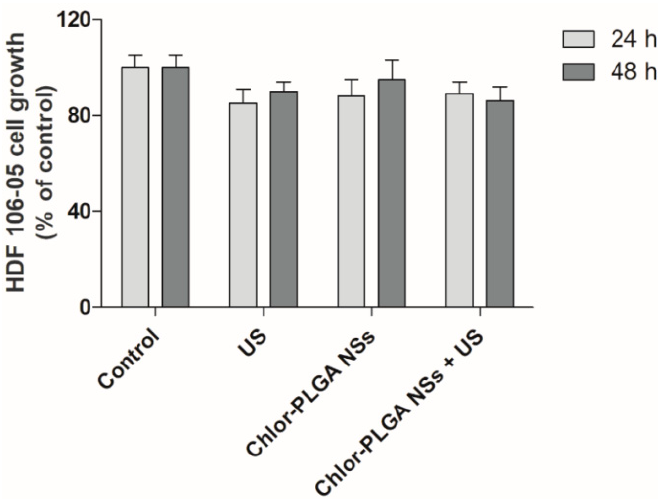
Figure 6. Effect of sonodynamic treatment on HDF 106-05 cell growth. Cells were incubated for 24 h with Chlor-PLGA NSs at the same concentration (5 µM) and then exposed to US at 1.5 MHz for 5 min at 1.5 W/cm 2 . Cell growth was evaluated after 24 and 48 h by WST-1 assay.